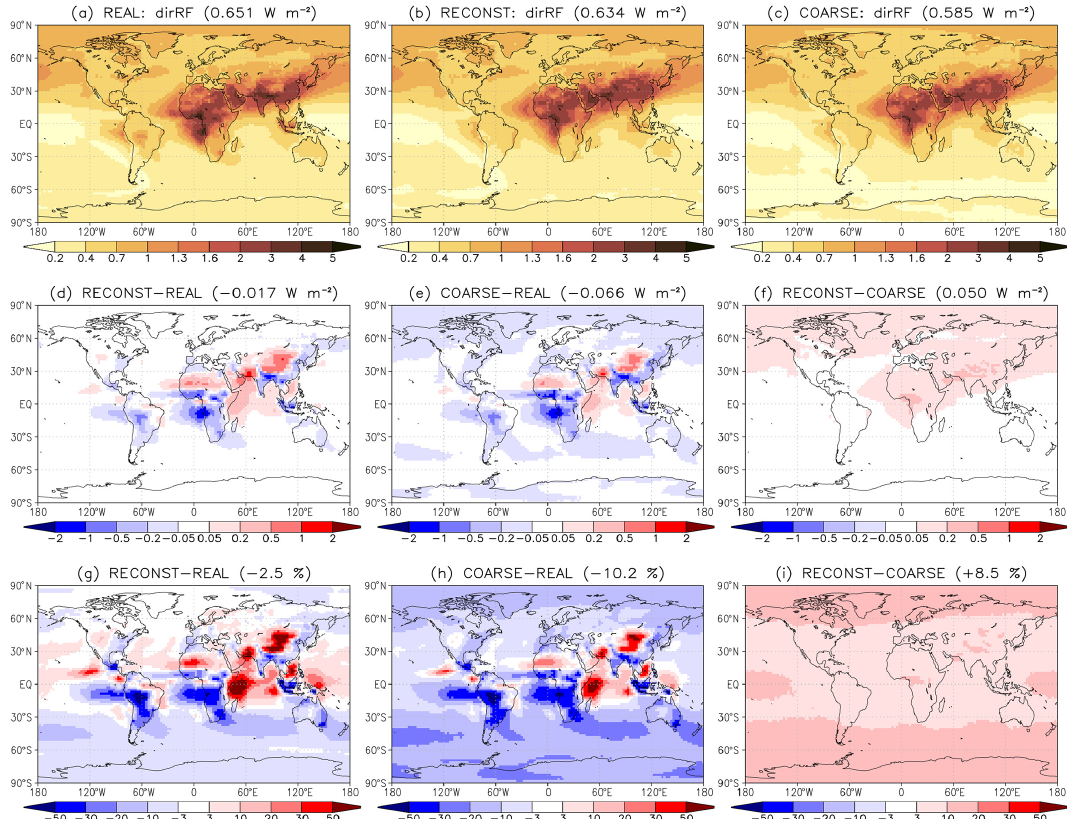
Figure 1. BC direct radiative forcing at the TOA (Wm − 2 ) in the experiments (a) REAL and (c) COARSE. Between them, panel (b) shows dirRF reconstructed using Eq. (4), which is identical for the two experiments. (d) Reconstruction errors (Wm − 2 ) for REAL. These errors are further decomposed into two parts, where (e) the difference between COARSE and REAL represents the emission error arising from the inability of the reconstruction to accurately represent the emissions in REAL, and (f) the difference between RECONST and COARSE (i.e., the reconstruction error for COARSE) is the additivity error that arises from nonadditivity and nonlinearity when combining the effect of BC emissions from different regions and seasons. (g) – (i) Relative errors corresponding to panels (d) – (f) (in %). Global mean values are indicated in the panel